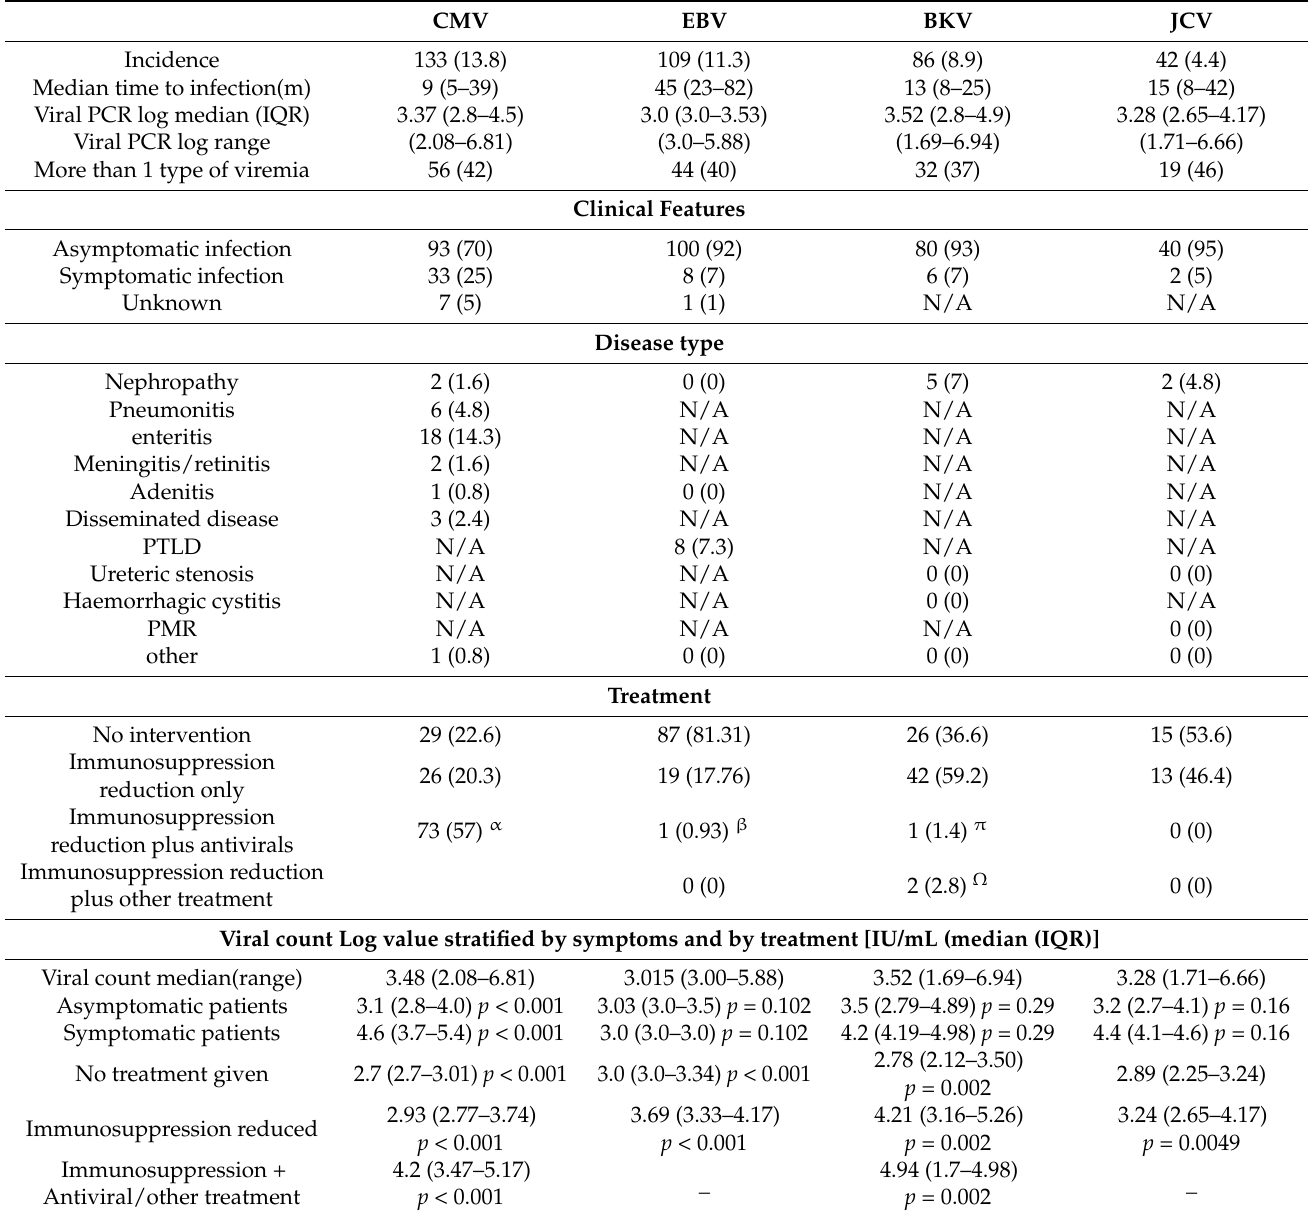
Table 2. Incidence, severity, clinical manifestations and treatments of the individual DNA viral infections. CMV BKV